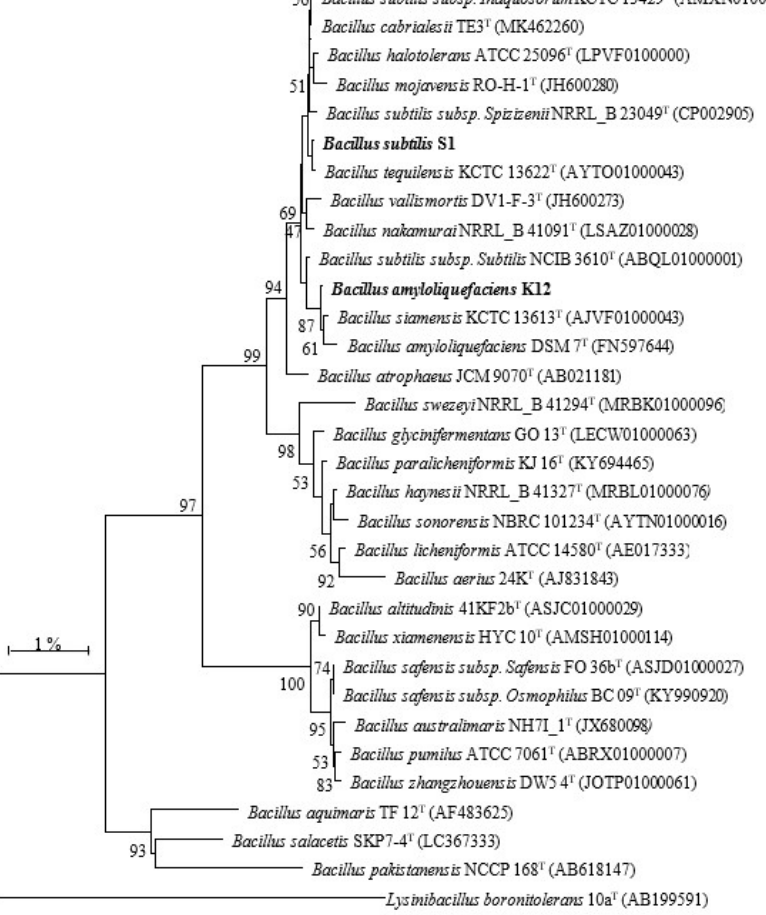
Figure 3. Phylogenetic analysis of strains S1 and KSM12 inferred from 16S rRNA gene sequence using Neighbor-Joining method based on the Kimura 2-parameter model. The type strain of Lysinibacillus boronitolerans was used as an outgroup.